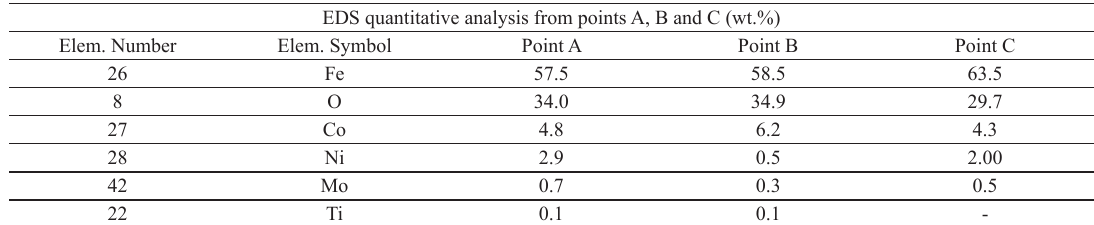
Table 4 summarizes the chemical composition obtained by energy-dispersive X-ray spectroscopy (EDS) near the nodule as depicted in Figure 7c.